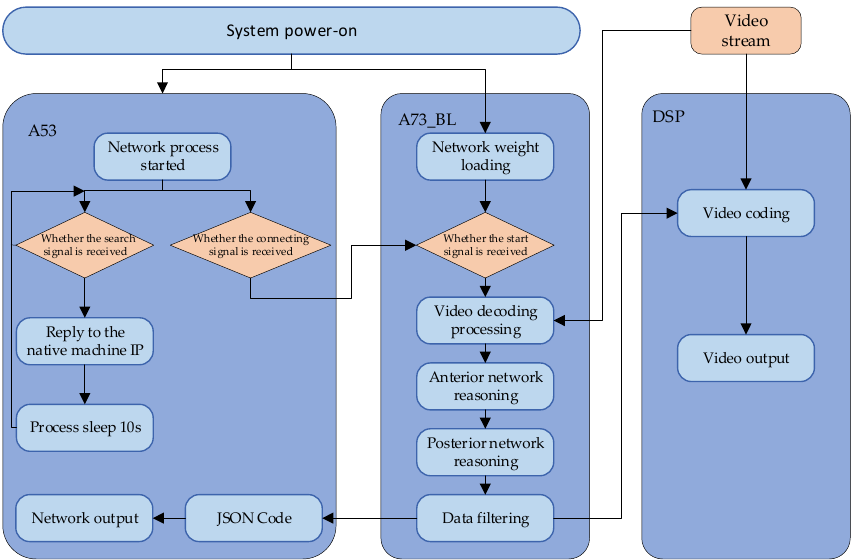
Figure 2. Block diagram for embedded software.